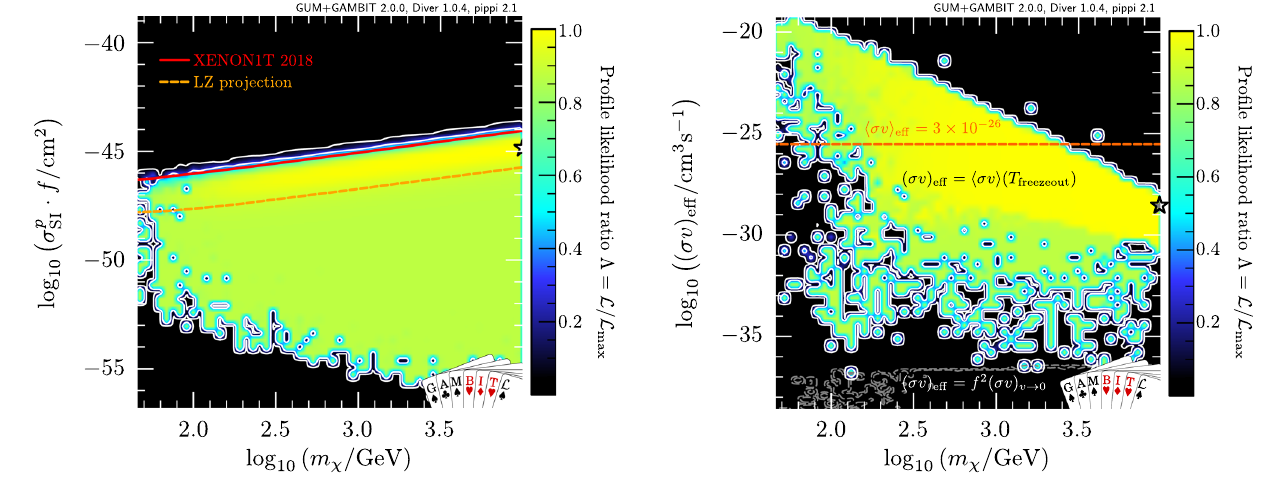
Fig. 4 Profile likelihood in the σ p Fig. 5 Profile likelihoods for the effective annihilation cross-section – m χ plane. The solid red line shows SI the exclusion from XENON1T [101] and the dotted orange line shows as a function of dark matter mass, at different epochs in the evolution the projection from LZ [108]. The spin-independent scattering cross- of the Universe. The dashed orange line signifies the canonical thermal section of dark matter with protons σ p cross-section (cid:6) σv (cid:7) = 3 × 10 − 26 cm 3 s − 1 . White contours with coloured is rescaled by the fraction of SI predicted relic abundance f ≡ Ω χ /Ω DM . Contour lines show the 1 and shading correspond to the thermal average cross-section at dark matter freezeout. The contours show the 1 and 2 σ confidence regions, and the 2 σ confidence regions. The white star shows the best-fit point white star the best-fit point. For comparison, in grey contours we show the 1 and 2 σ confidence regions for the annihilation cross-section in the v → 0 limit, rescaled by the square of the fraction of the predicted relic abundance, f ≡ Ω χ /Ω DM . This is the effective annihilation cross- section that enters indirect detection rates in the late Universe